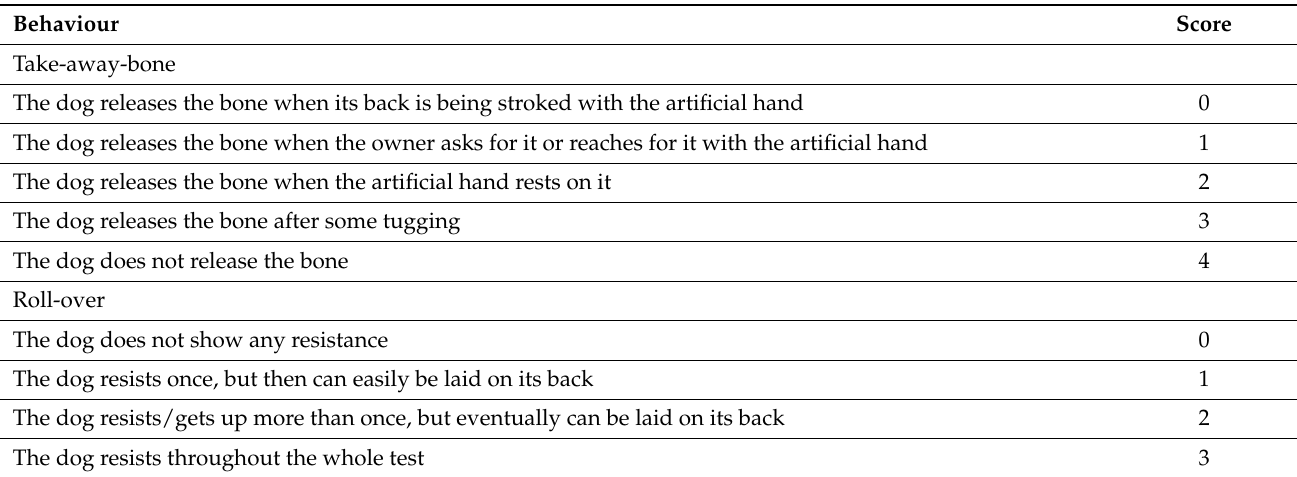
Table 2. Variables measured in the Take-away-bone and Roll-over tests based on B á lint et al. [40]. Behaviour Score